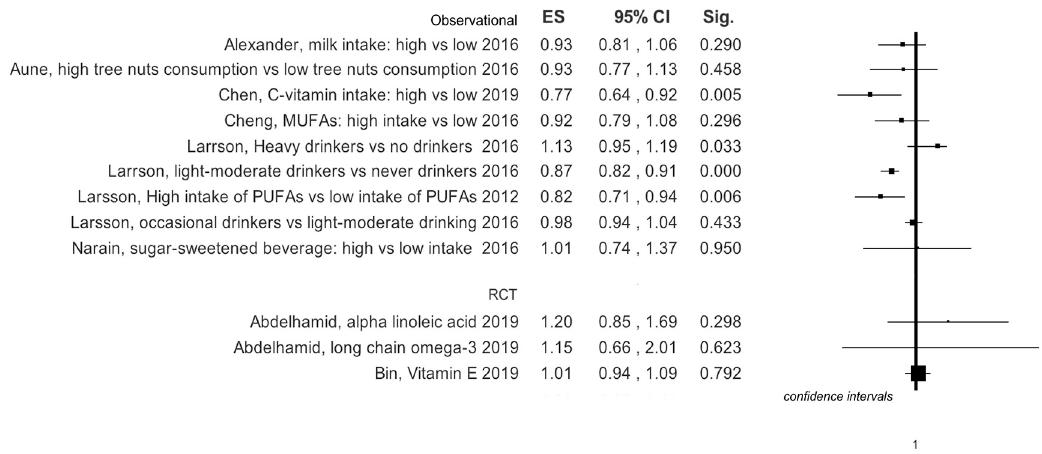
Figure 5. Summary results of effects size for ischemic of stroke events, based on study design of selected primary studies for each meta-analysis.